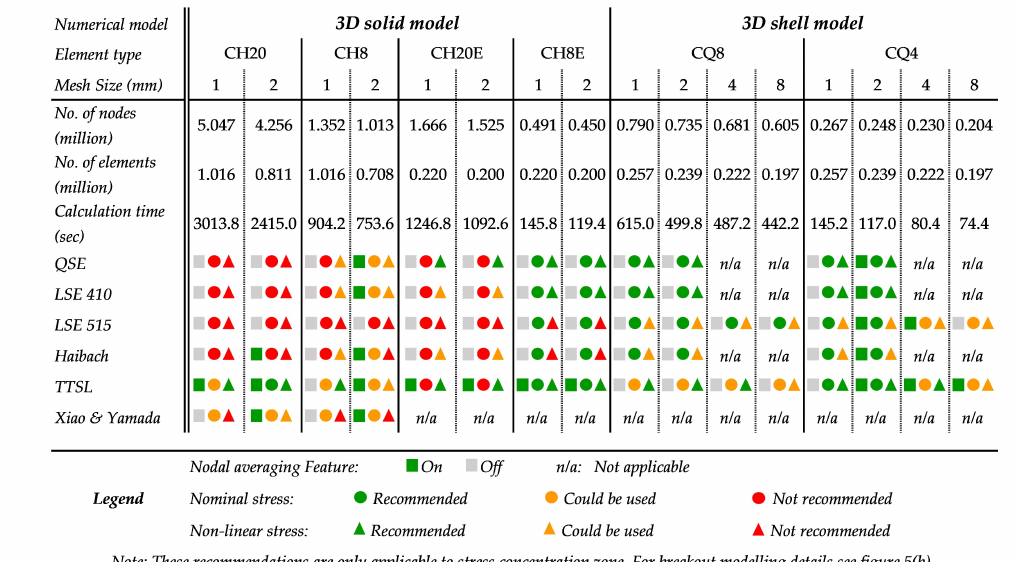
Figure 10. Guidelines for the evaluation of SHSS considering di ff erent mesh techniques used in this